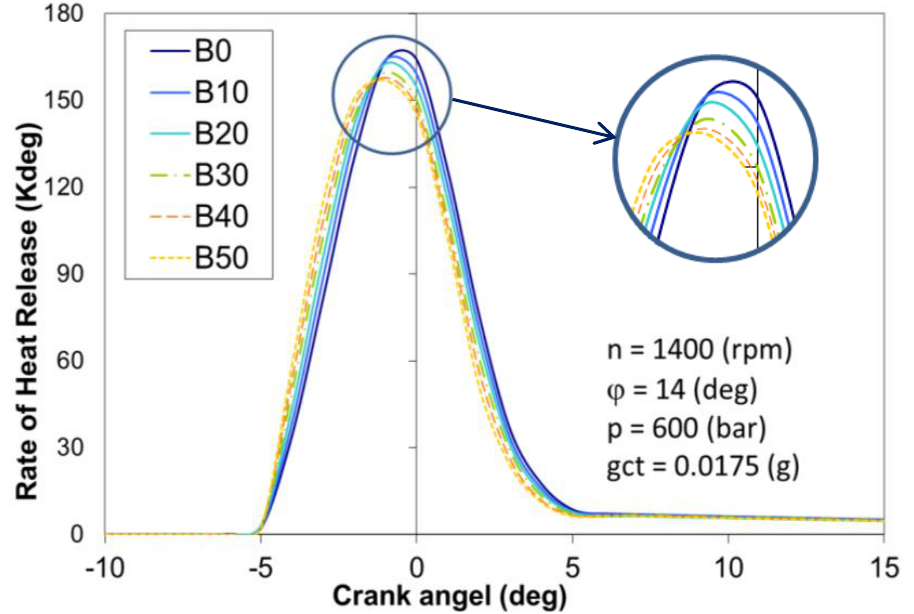
Figure 7. Variation of heat release rate values with respect to crank angle. The specific parameters of combustion process are shown in Table